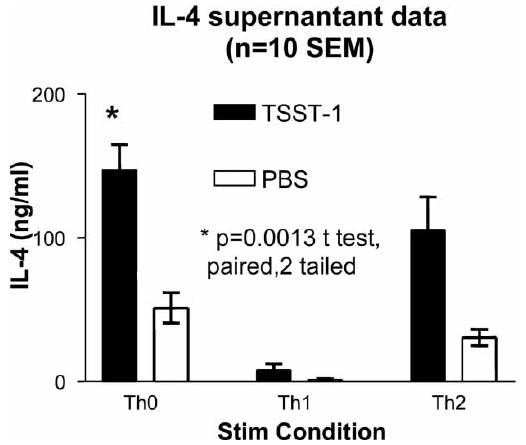
FIG. 4. Absolute IL-4 production by T h cells isolated from repeatedly invivoPBS or TSST-1 treated mice as detected by ELISA (detection limit, 7.5 pg/ml) under different in vitro polarising conditions, including T h 0, T h 1 and T h 2